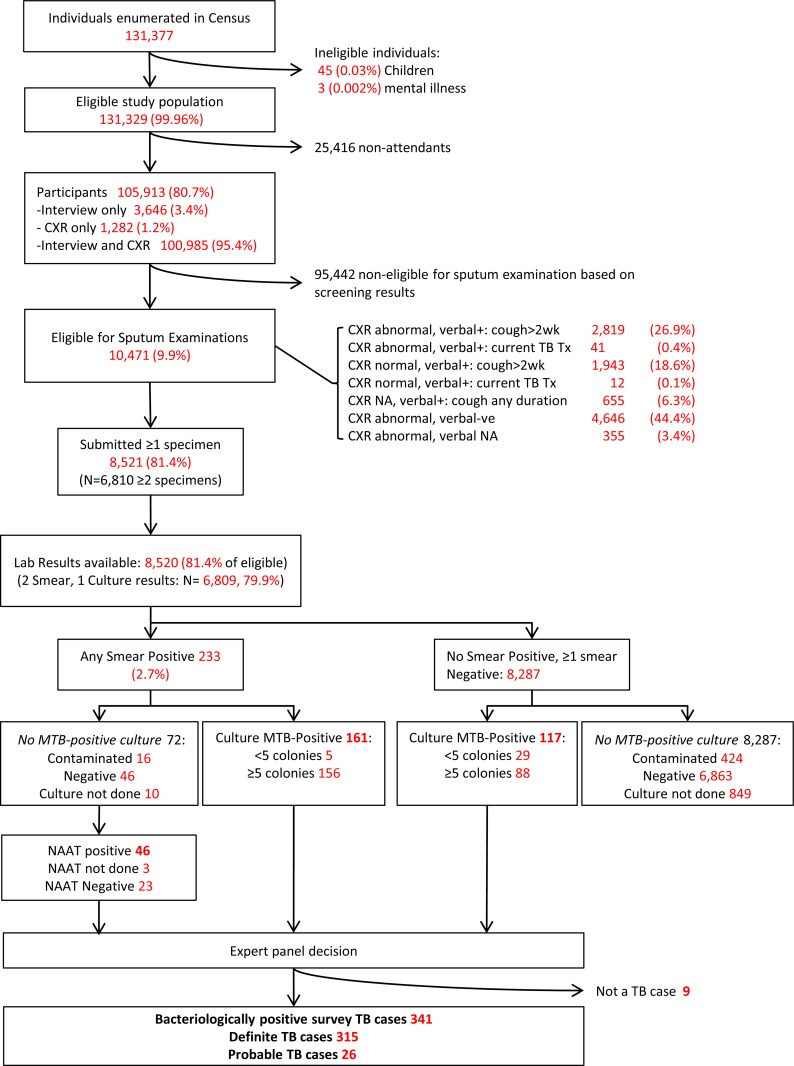
Flow Diagram of National Prevalence Survey of Pakistan, 2010–11.